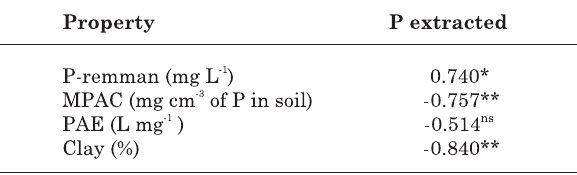
ns, *, **: non-significant and significant at the level of 5 and 1 %, respectively, MPAC: maximum P adsorption capacity; PAE: P Adsorption